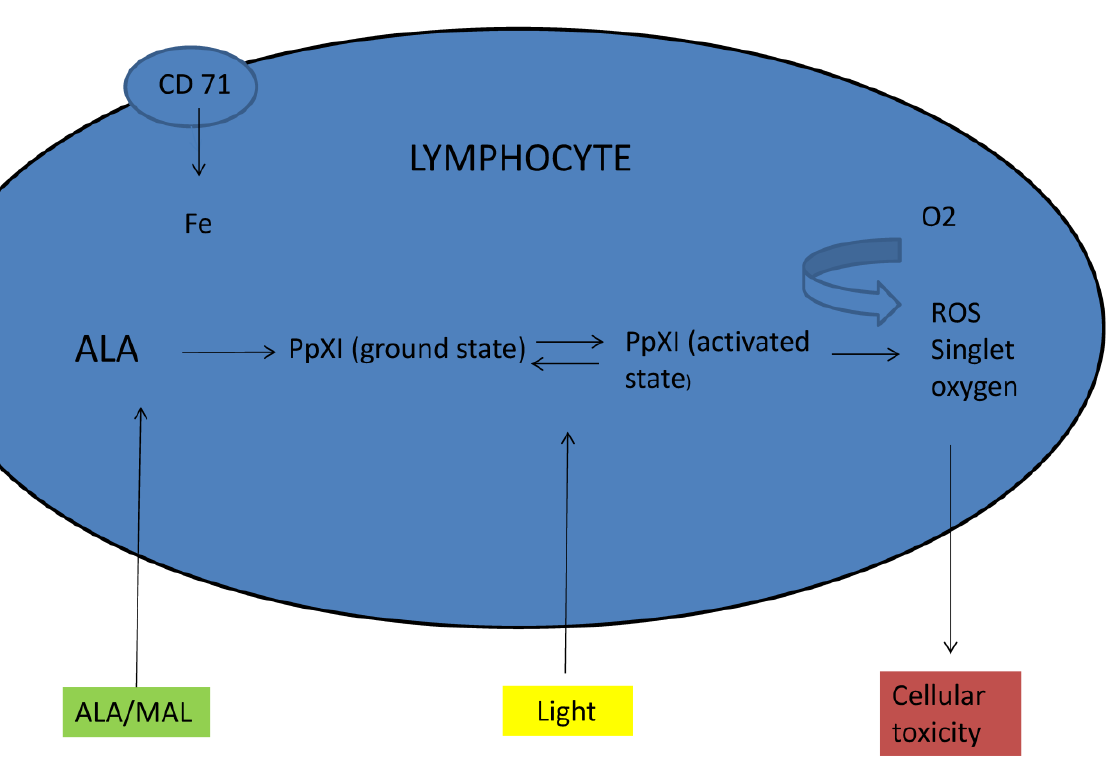
Figure 2. Schematic image of PDT effects in malignant lymphocytes of